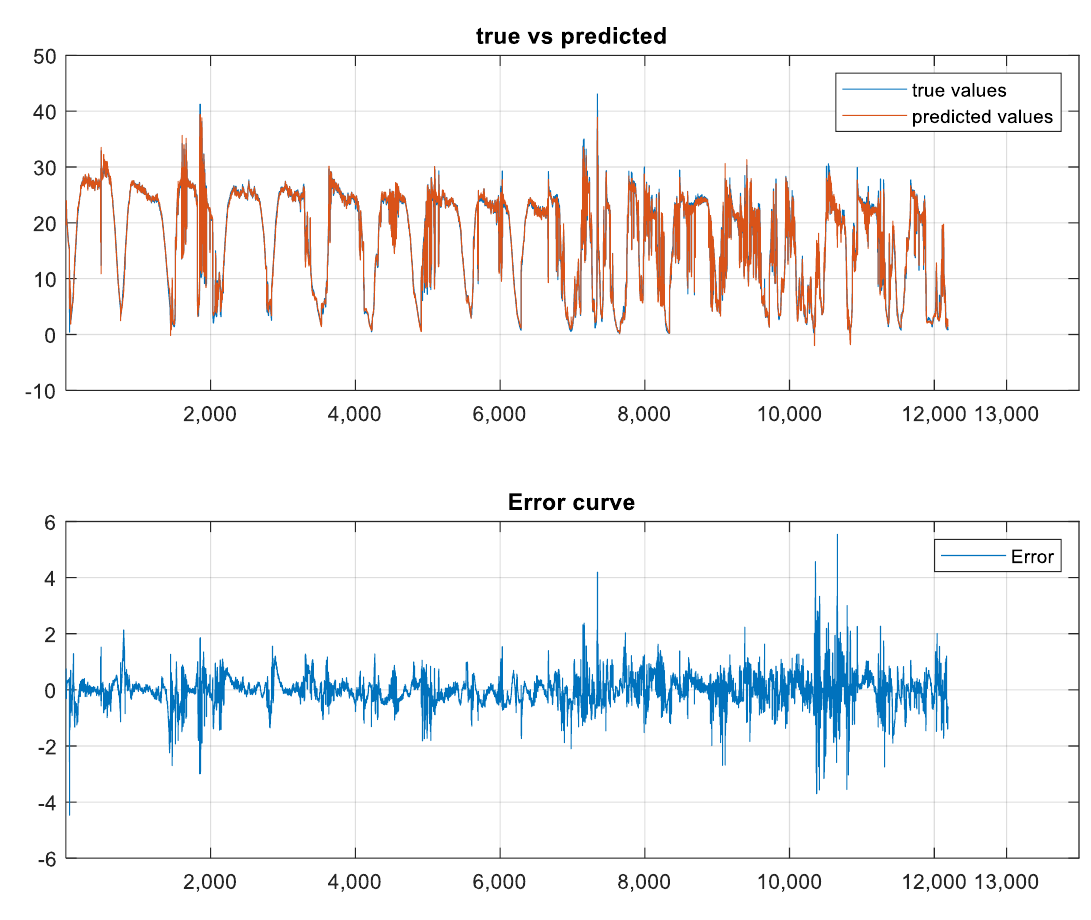
Figure 8. Error and output of PSO–ANN results.